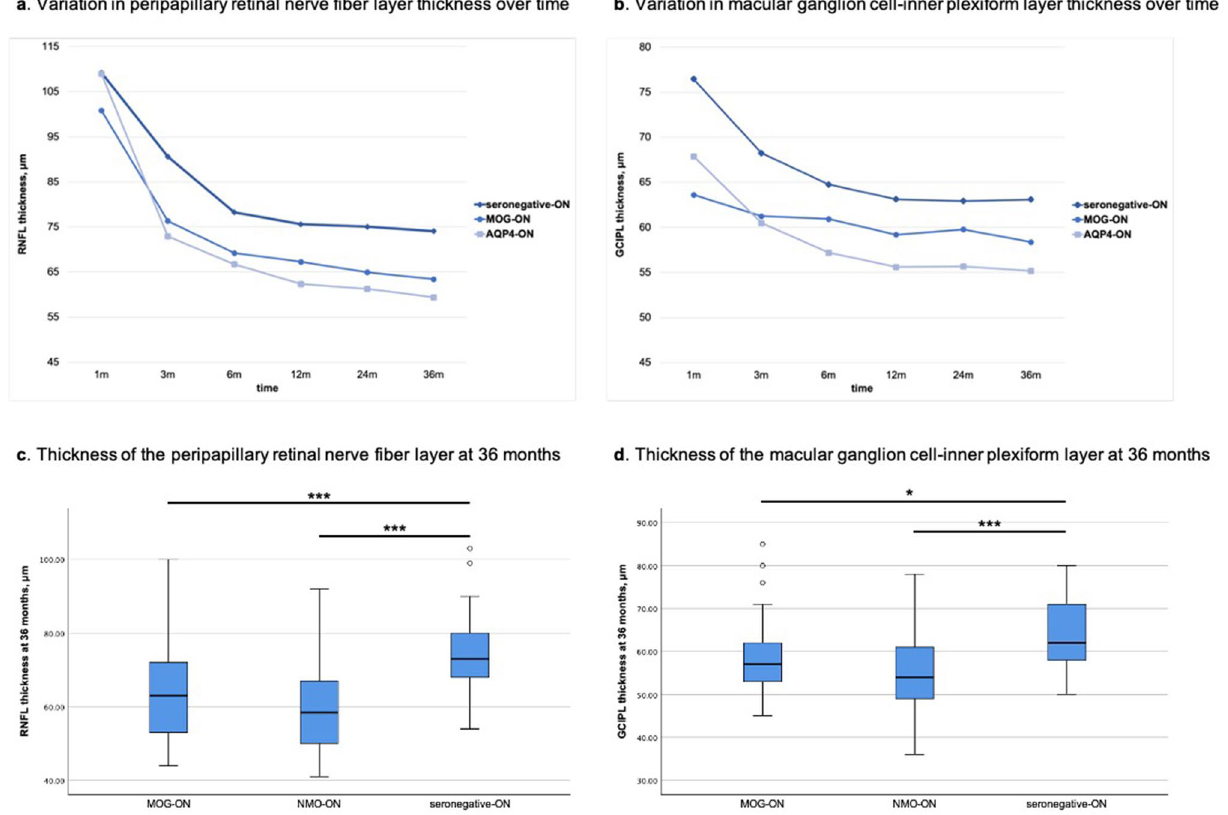
Figure 1. Line graphs and box-and-whisker plots of peripapillary retinal nerve fiber layer (RNFL) and macular ganglion cell-inner plexiform layer (GCIPL) thickness. MOG, myelin oligodendrocyte glycoprotein; ON, optic neuritis; AQP-4, aquaporin